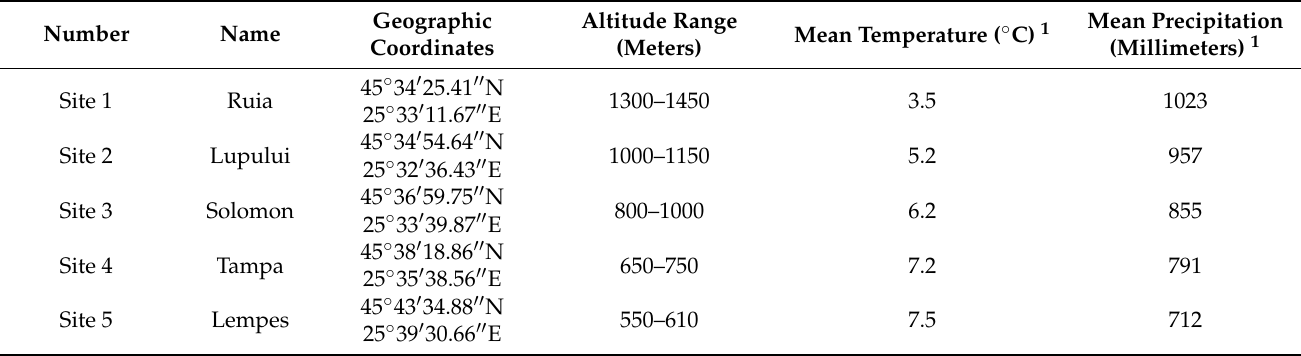
Table 1. Description of study sites.